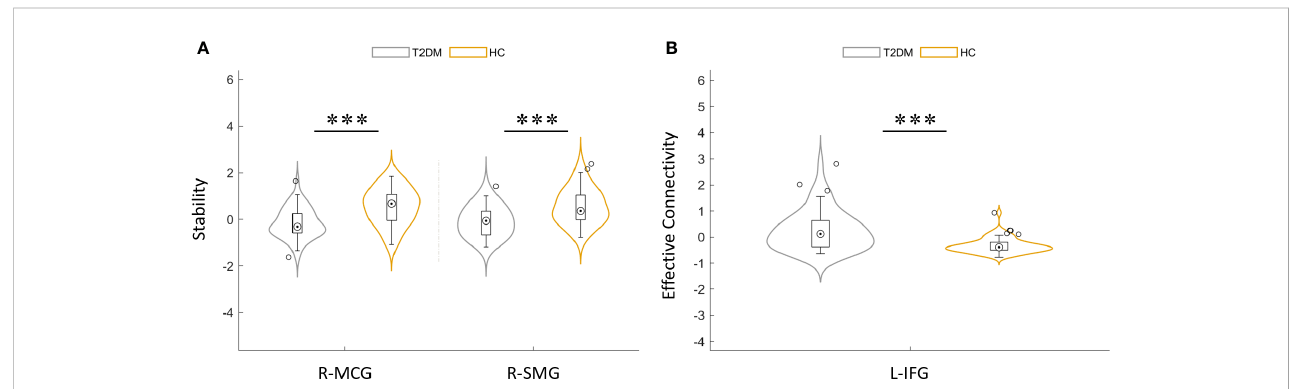
FIGURE 3 (A) Distribution comparison of dynamic functional stability between T2DM group and HCs. (B) Distribution comparison of dynamic effective connectivity between the T2DM group and HCs. MCG, median cingulate gyrus; SMG, supra-marginal gyrus; IFG, inferior frontal gyrus; L, left; R, right. ***P<